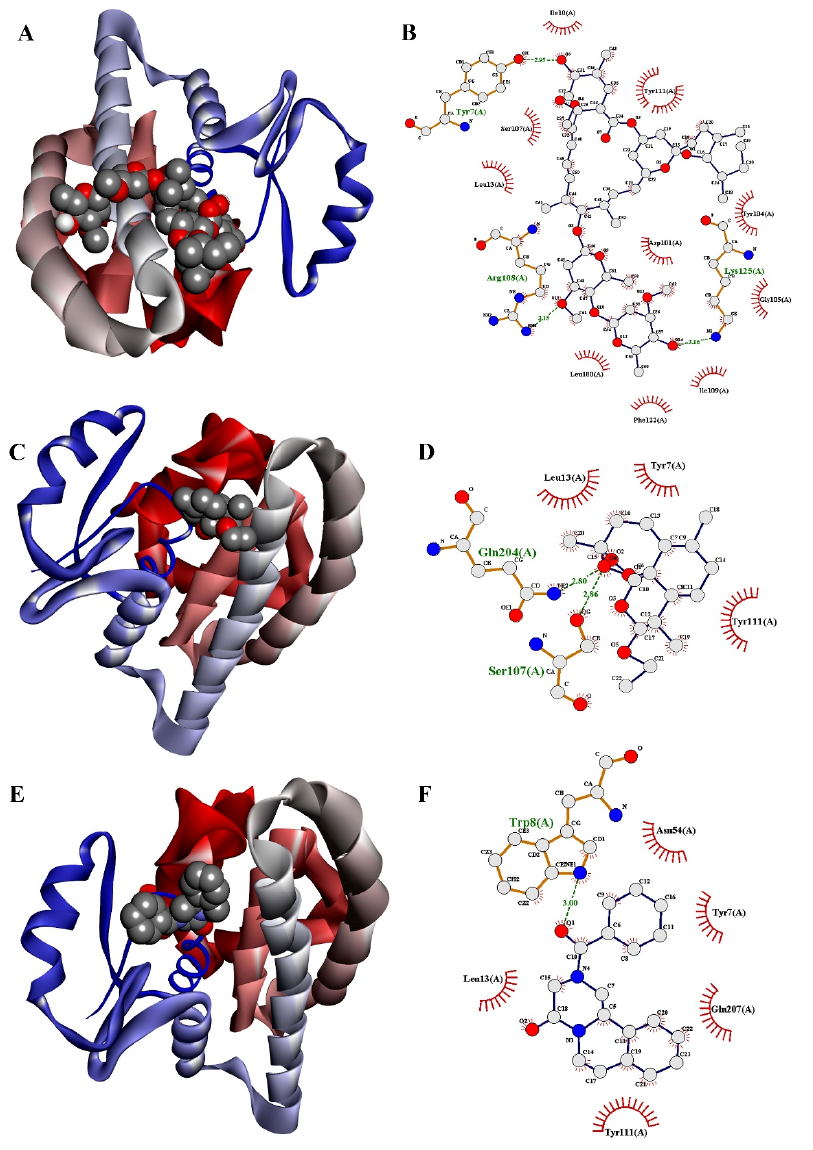
Figure 4. Three-dimensional and two-dimensional docked poses of GST-ligand complex for ( A , B ) ivermectin; ( C , D ) arteether; and ( E , F ) praziquantel.